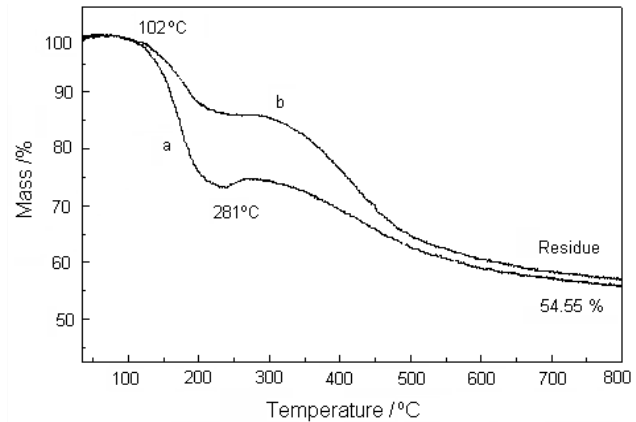
Figure 4. The thermal gravimetric (TG) curves of citral ( a ) and VS ‐ citral ( b ) under the conditions of an increased speed of 20 °C/min and a temperature range of 0–800 °C.